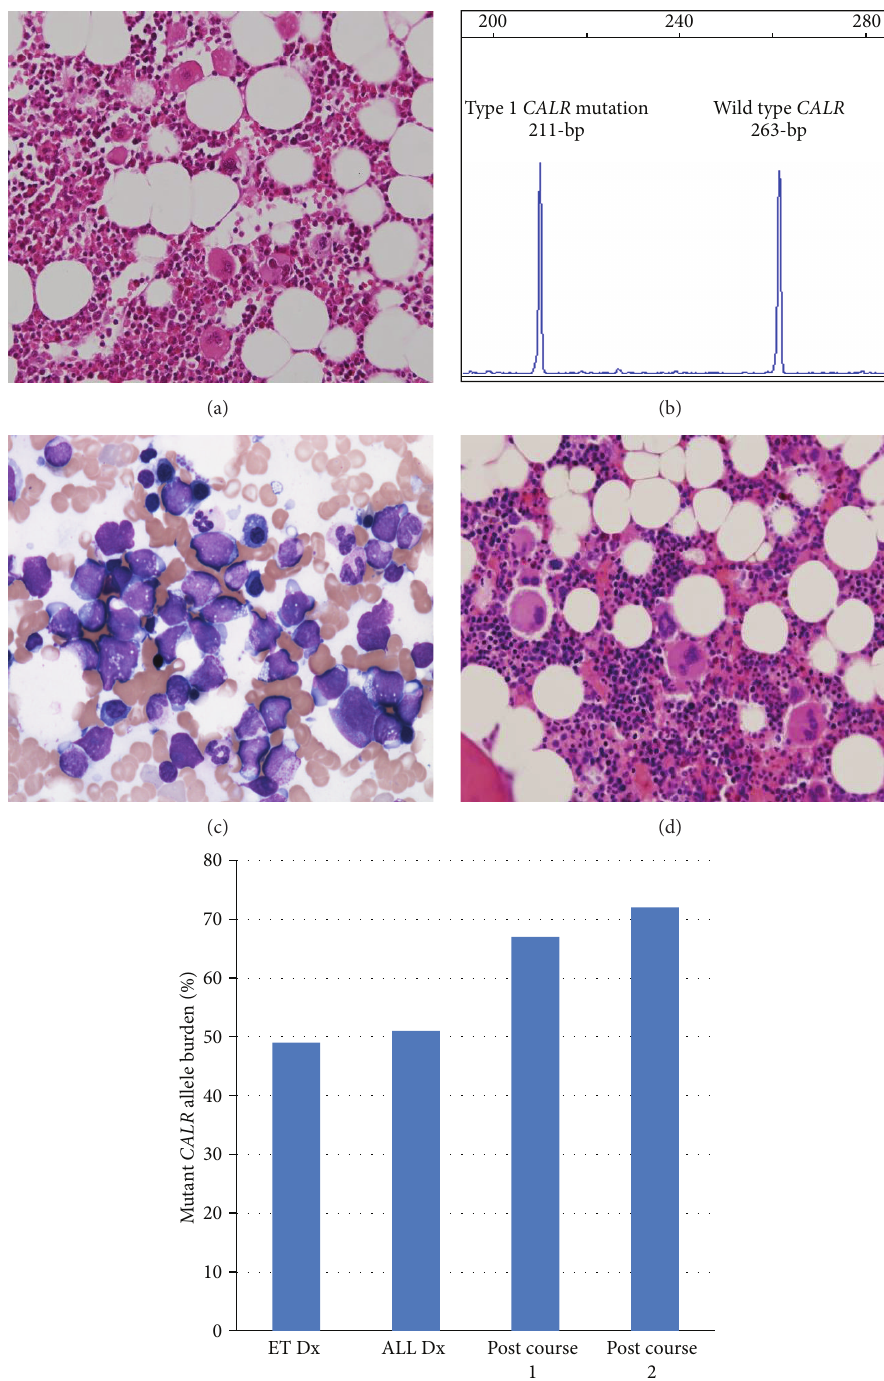
Figure 1: (a) Bone marrow trephine biopsy at diagnosis of essential thrombocythemia (Hematoxylin and Eosin; magnification × 20); (b) fragment length detection of the CALR mutation; (c) bone marrow aspirate at diagnosis of acute lymphoblastic leukemia; (d) bone marrow trephine biopsy following two courses of chemotherapy (Hematoxylin and Eosin; magnification × 20); (e) mutant CALR allele